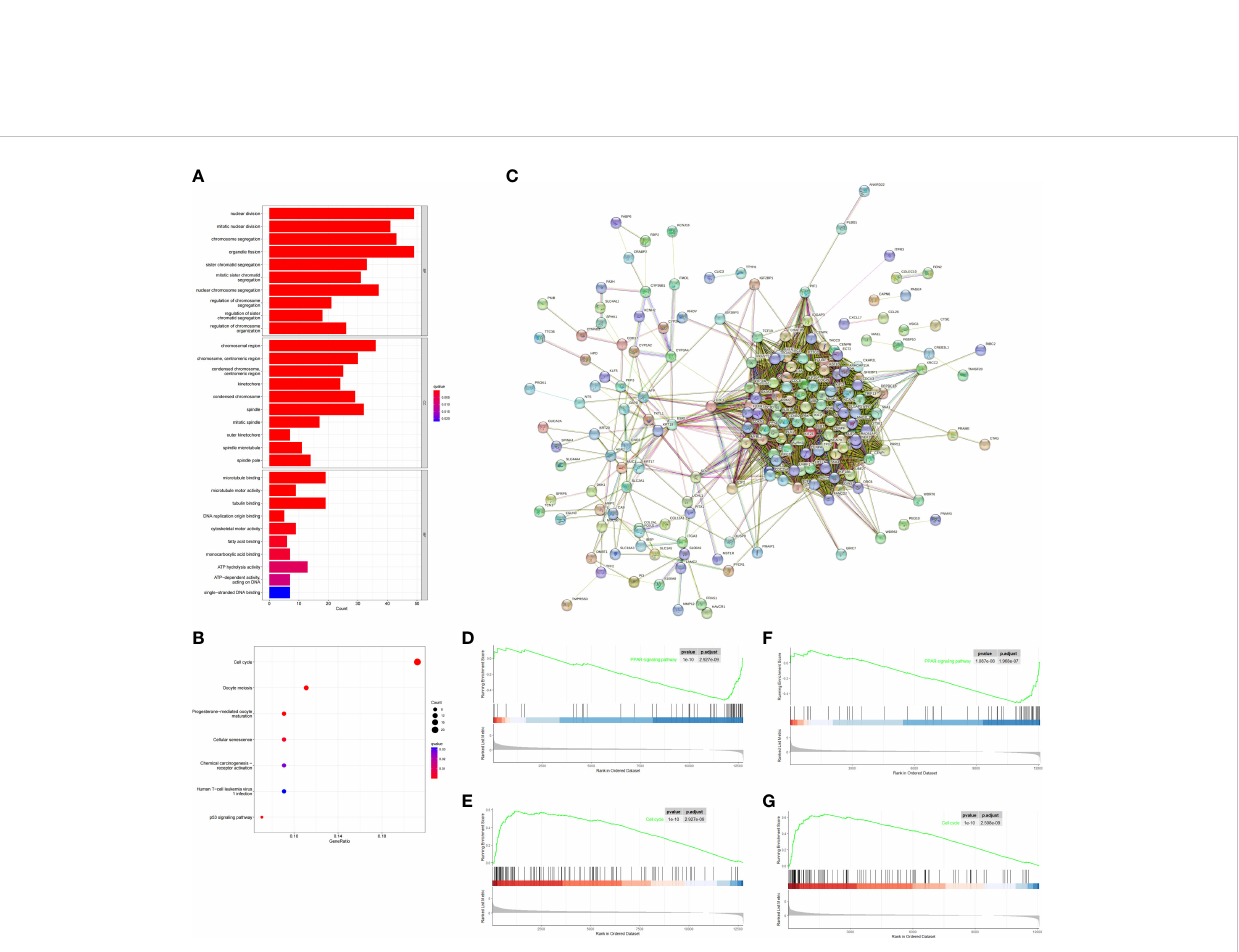
FIGURE 5 Functional analysis based on the DEGs between the two-risk groups in the TCGA and ICGC cohort. (A) Barplot graph for GO enrichment (the longer bar means the more genes enriched, and the increasing depth of red means the differences were more obvious; q-value: the adjusted p value). (B) Bubble graph for KEGG pathways. The larger bubble means the more genes enriched, and the increasing depth of red means the differences were more obvious. q-value, the adjusted p value. (C) PPI network of 229 DEGs. (D – G) Two representative Kyoto Encyclopedia of Genes and Genomes (KEGG) pathways via GSEA in TCGA cohort (D, E) , ICGC cohort (F, G)